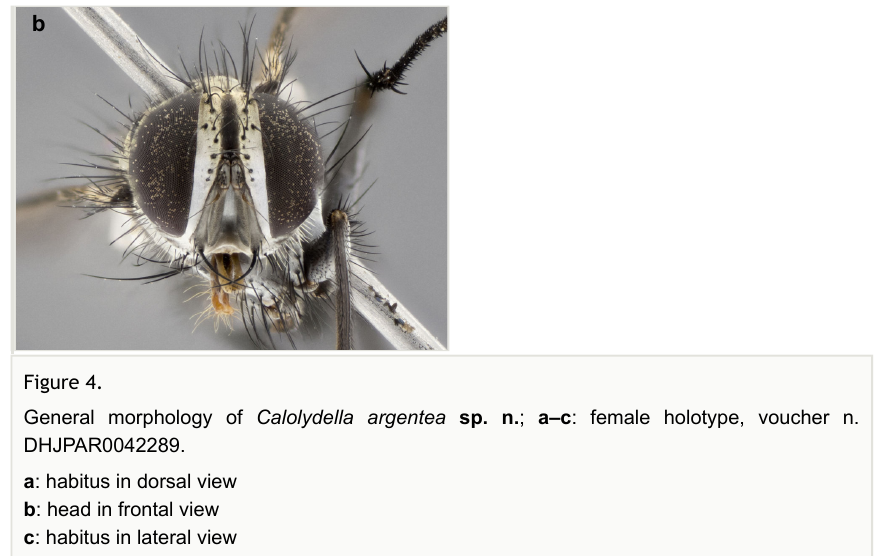
Male : not known at this time. Diagnosis Calolydella argentea can be distinguished from all other species of Calolydella by the setae extending to base of postpedicel with intermingled small setulae, 3:3 acrostichal crossvein R-M.